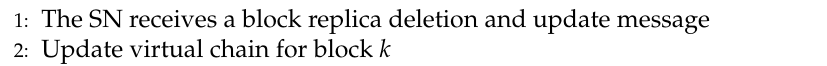
Algorithm 4 Block replica deletion and update